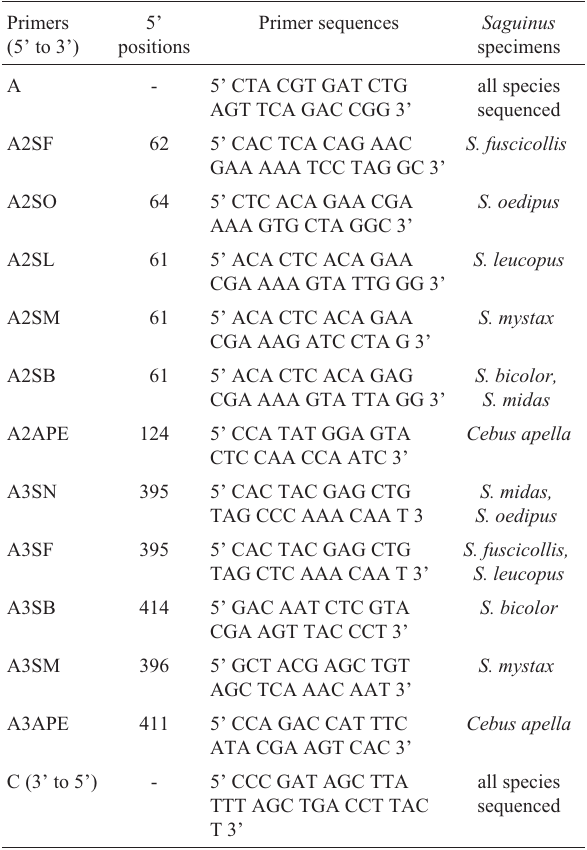
Table 2 - Internal primers for the mitochondrial DNA ND1 flanking regions of Cebus apella and several Saguinus